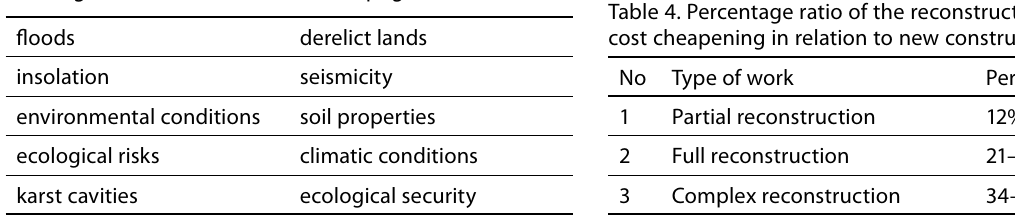
Table 4. Percentage ratio of the reconstruction